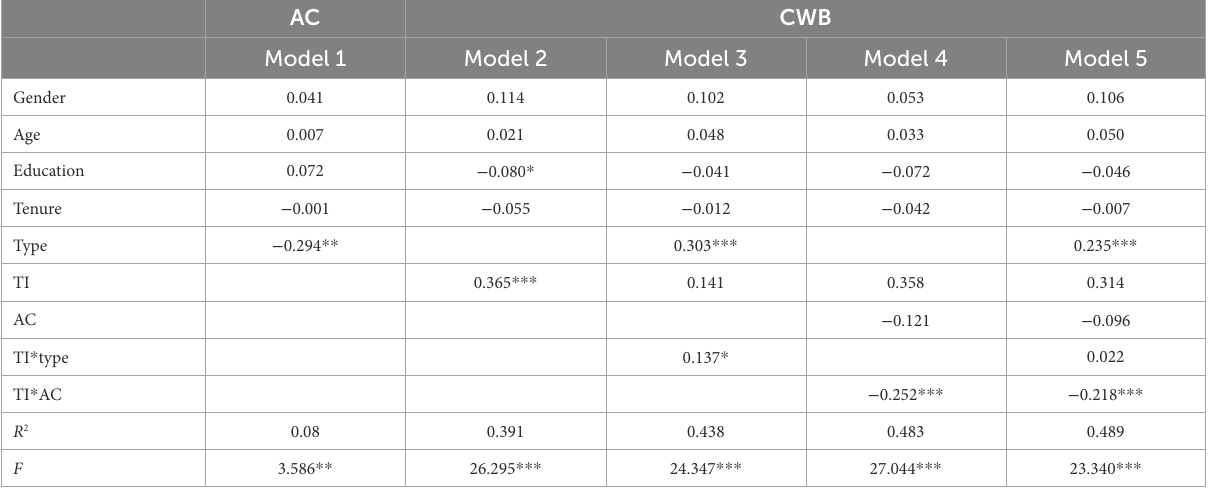
TABLE 2 Hierarchical regression